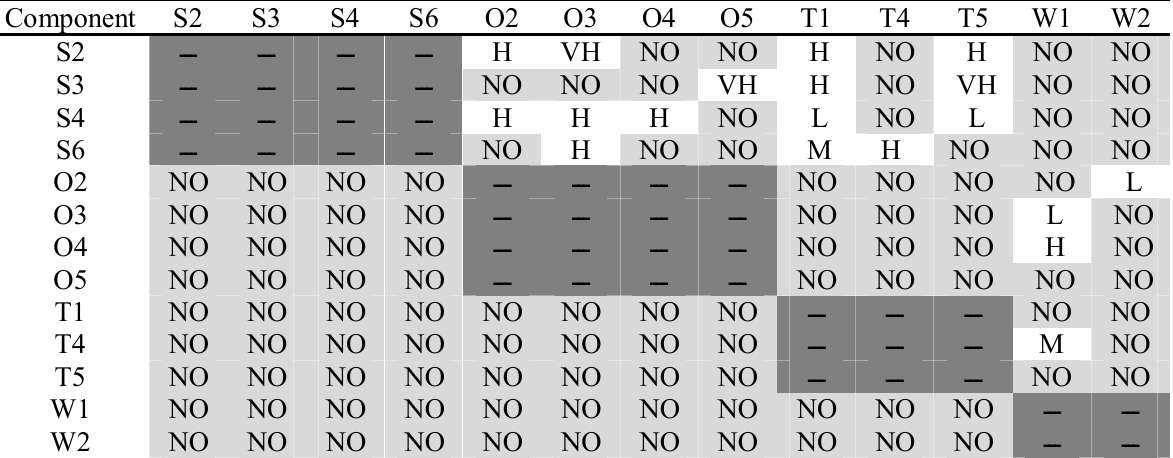
The summary of relationship between various components